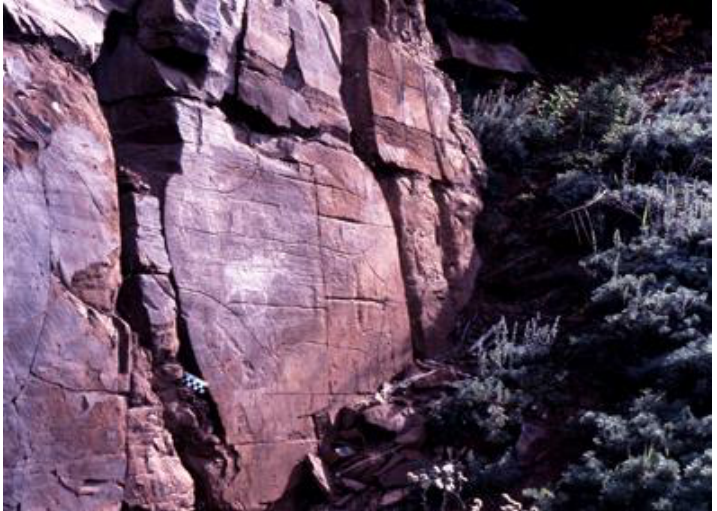
Figure 11. Zoomorphic pictograms at the large petroglyph site Shishkino on the